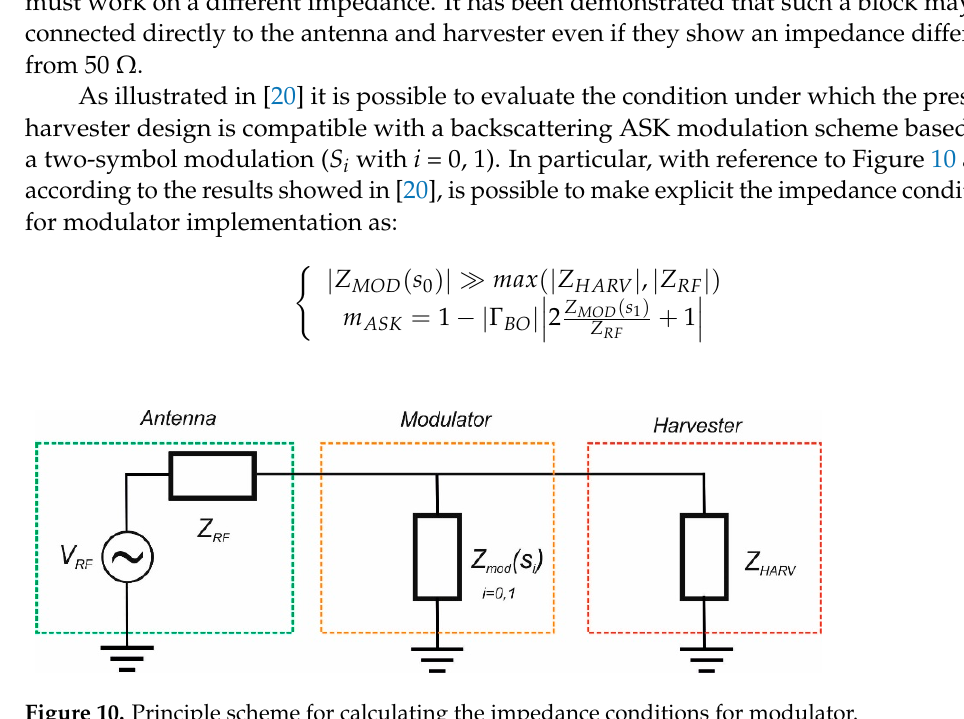
Table 2. List of the geometric parameters of the antenna design. All dimensions are in mm.